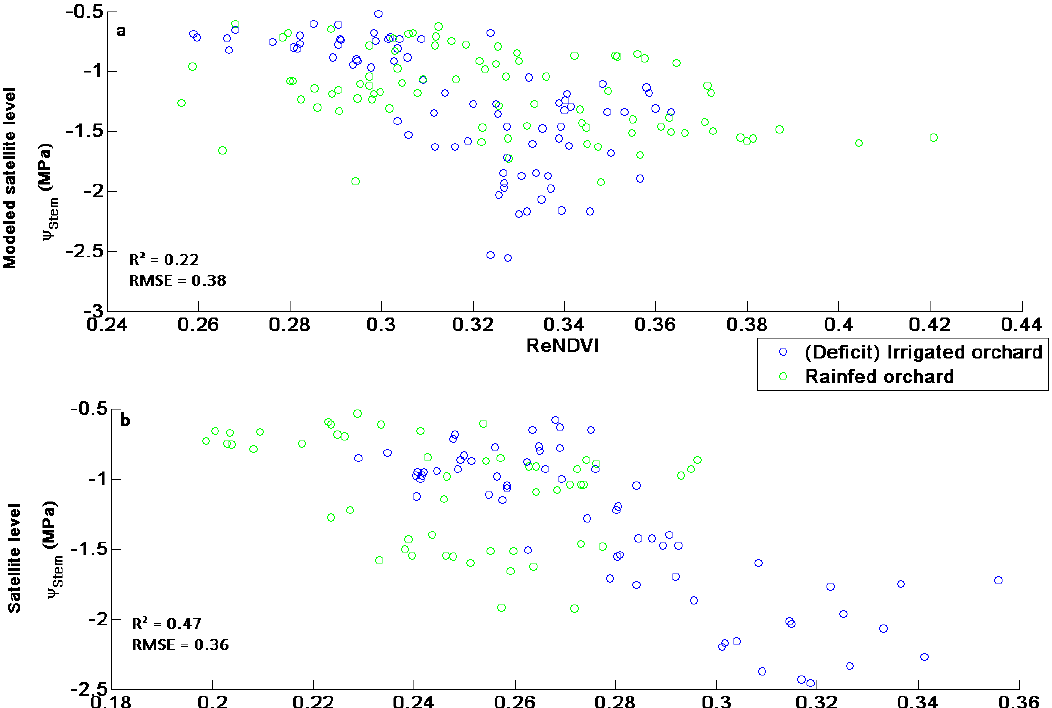
; MPa) for the modeled satellite stem